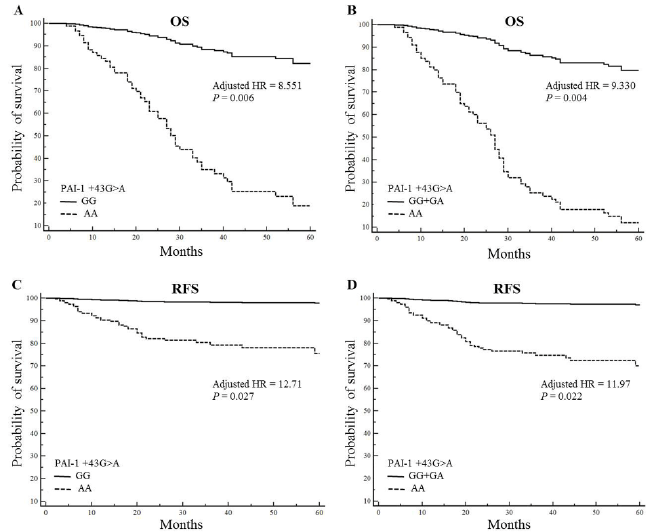
Figure 2. Overall survival (OS; A, B) rates and relapse-free survival (RFS; C, D) rate of the PAI-1 + 43G > A polymorphism in colorectal cancer patients. ( A ) OS curves of patients in the PAI-1 + 43GG vs. + 43AA group. ( B ) OS curves of patients in the PAI-1 + 43GG + GA vs. + 43AA group. ( C ) RFS curves of patients in the PAI-1 + 43GG vs. + 43AA group. ( D ) RFS curves of patients in the PAI-1 + 43GG + GA vs. + 43AA group.